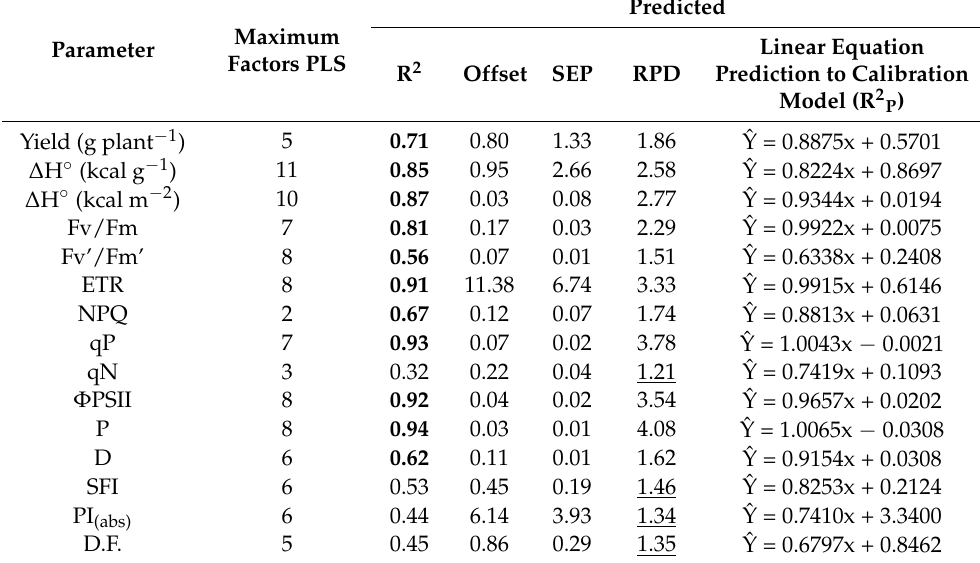
Table 3. Statistical metrics from the PLSR model in the predicted phase. Maximum number of components used (factors PLS), model goodness-of-fit (R 2 ), offset, standard error of prediction (SEP), ratio of performance to deviation (RPD) and linear equation prediction ( ˆY) to base models (a prediction using an independent sample coupling to calibrated models) parameters of yield, calorimetry and chlorophyll a fluorescence parameters from hyperspectral data of date tobacco leaves. Bias outputs are not shown, as they were always lower than 0.01 to predict regression analysis. Parameter abbreviations—see Table 1. The bold represents statistically significant regression models (R 2 ). The underline indicates a bad residual prediction deviation (RPD) was calculated.